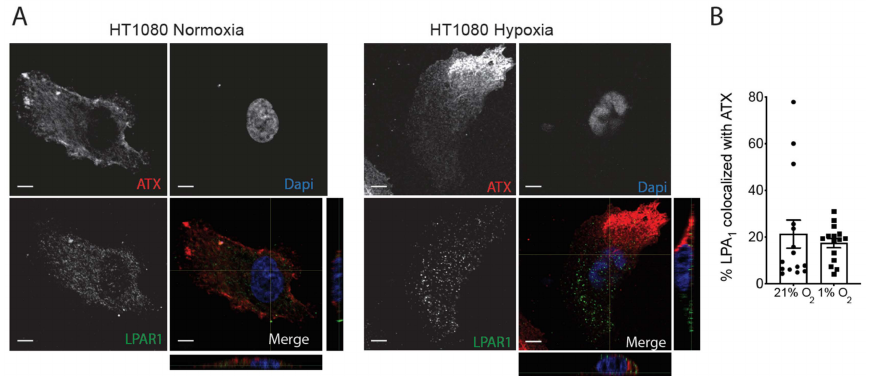
Figure 7. Localization of LPAR1 in hypoxic cancer cells. HT1080 cells were cultured on non-fluorescent gelatin for 4h in normoxia (21% O 2 ) or hypoxia (1% O 2 ). ( A ) Representative immunofluorescence images of cells stained for LPAR1 (green) and ATX (red). Nuclei were stained with DAPI (blue). Magnification 60 × , scale bars, 5 µ m. ( B ) Quantification of the percentage of LPAR1 colocalized with ATX in HT1080 cells. Bars represent the mean ± SEM.